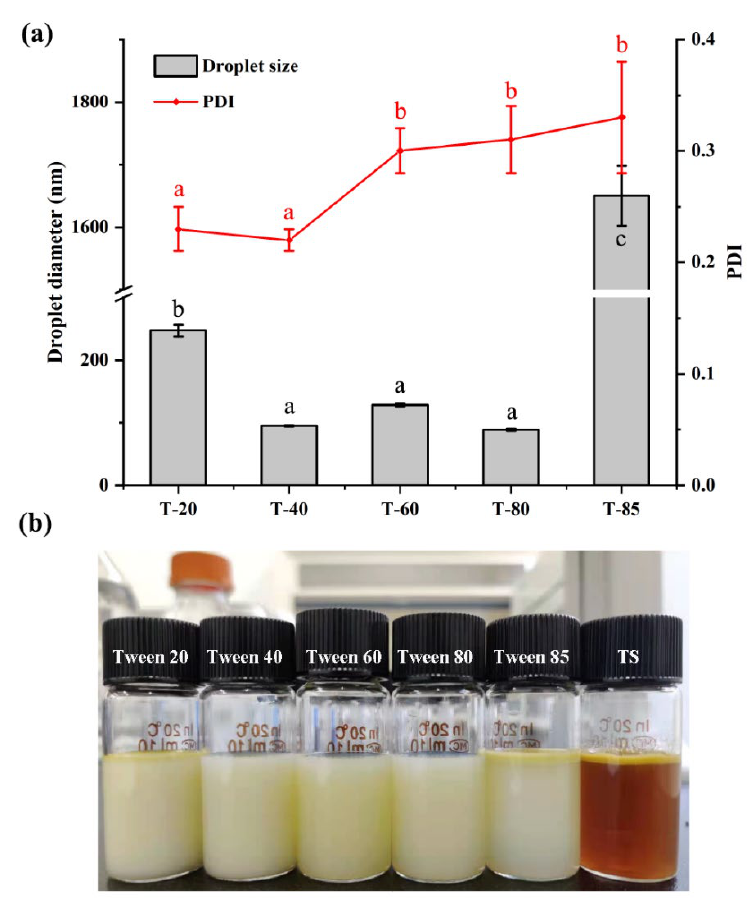
Figure 1. ( a ) Effect of synthetic surfactant and TS on the average droplet size and PDI of ZBEO based nanoemulsions prepared by EPI method. ( b ) Appearance of ZBEO emulsions after storage over night at ambient temperature. ZBEO emulsions were produced using the same oil phase concentration (5 wt%) with different surfactant types (surfactant-to-oil ratio (SOR) of 1:1). abc , means within the same column followed by the same letter are not significantly different ( p > 0.05) in one-way analysis of variance and Duncan’s